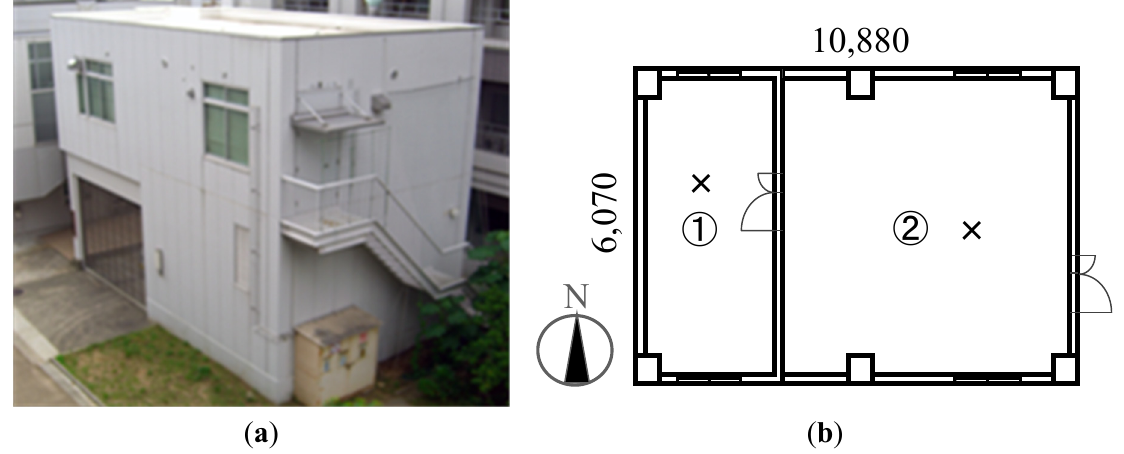
Figure 1. ( a ) Facade and ( b ) Plan (second floor) of test building (x: Measurement point in Figure